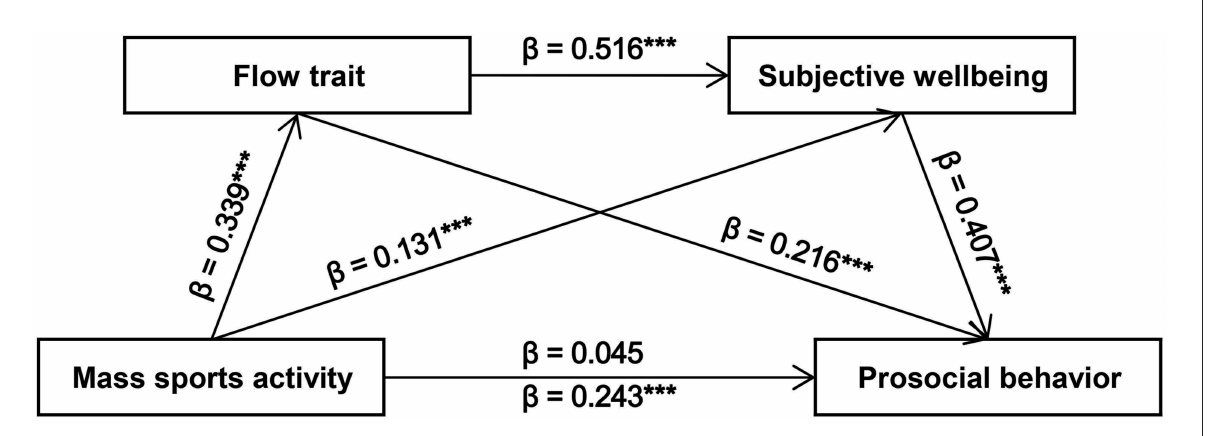
FIGURE1 Conceptual diagram of double mediation using the PROCESS (Template, Model 6). Beta values above the solid line represent indirect effects, while the beta value below the solid line represent the total effect. *** Denotes P <